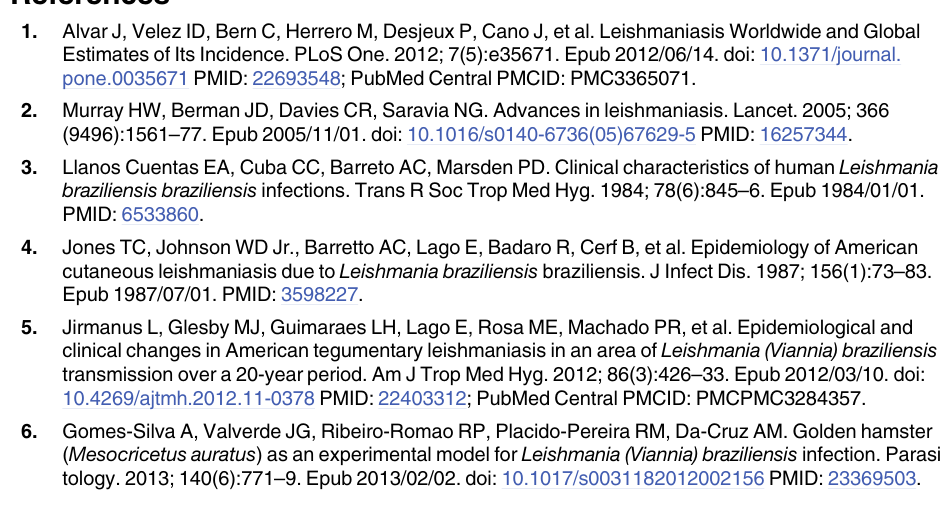
S3 Fig. In vivo efficacy of miltefosine in L . braziliensis -inoculated BALB/c mice. 10 6 Lb -WT stationary-phase promastigotes were injected in the mice left hind footpad. Treatment with 5 or 15 mg/kg/day of miltefosine was given for 15 consecutive days (from 4 th to 6 th week post- inoculation). Average of lesion size was measured weekly (five animals per group) in untreated and treated animals The horizontal black bar indicates MF treatment and the arrows indicate the time points when parasites were recovered from BALB/c mice treated with 5 or 15 mg/kg/ day (19 th and 23 th week